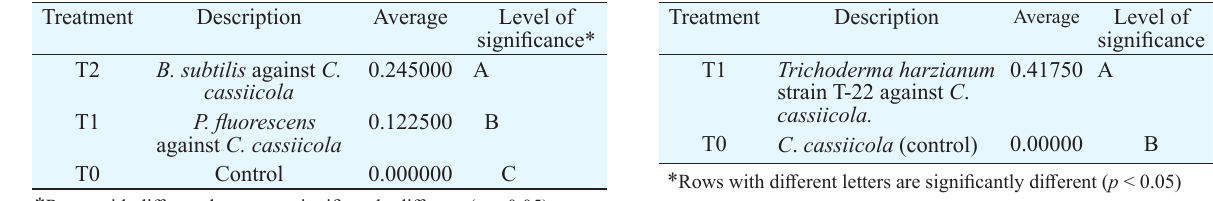
Table 6. Results of the analysis of variance for the percentage mycelial inhibition of Trichoderma harzianum strain T-22 against Corynespora cassiicola